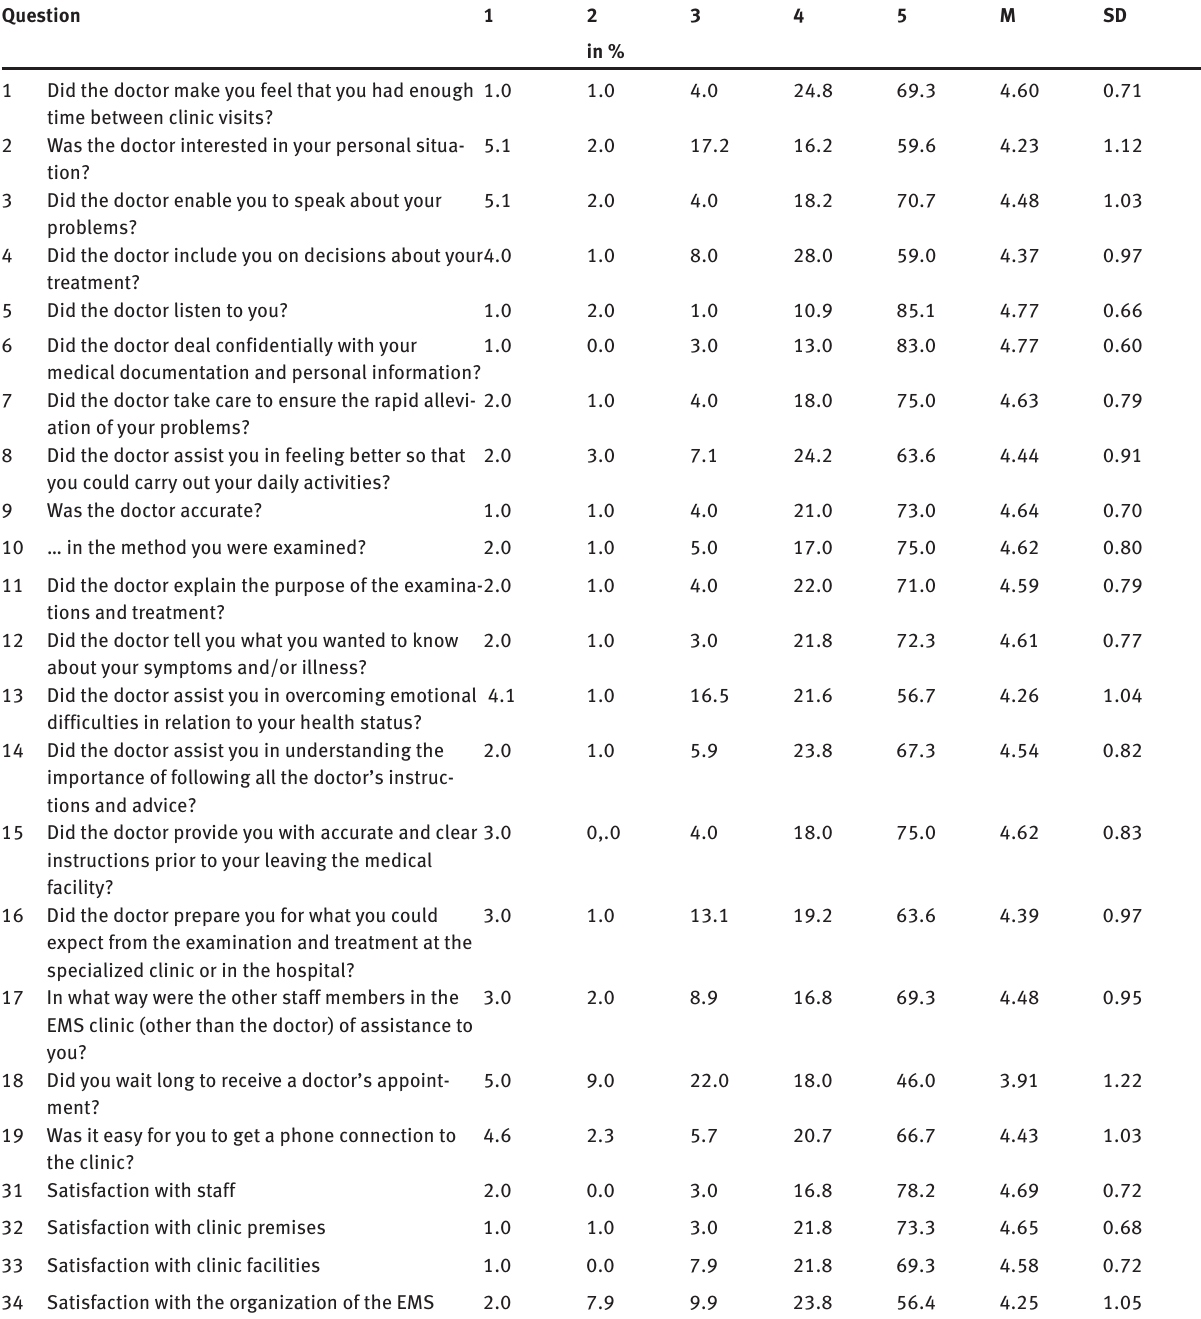
Table 1: Patient opinion on EMS and patient satisfaction with EMS clinic (legend: M – median value, SD – standard deviation)